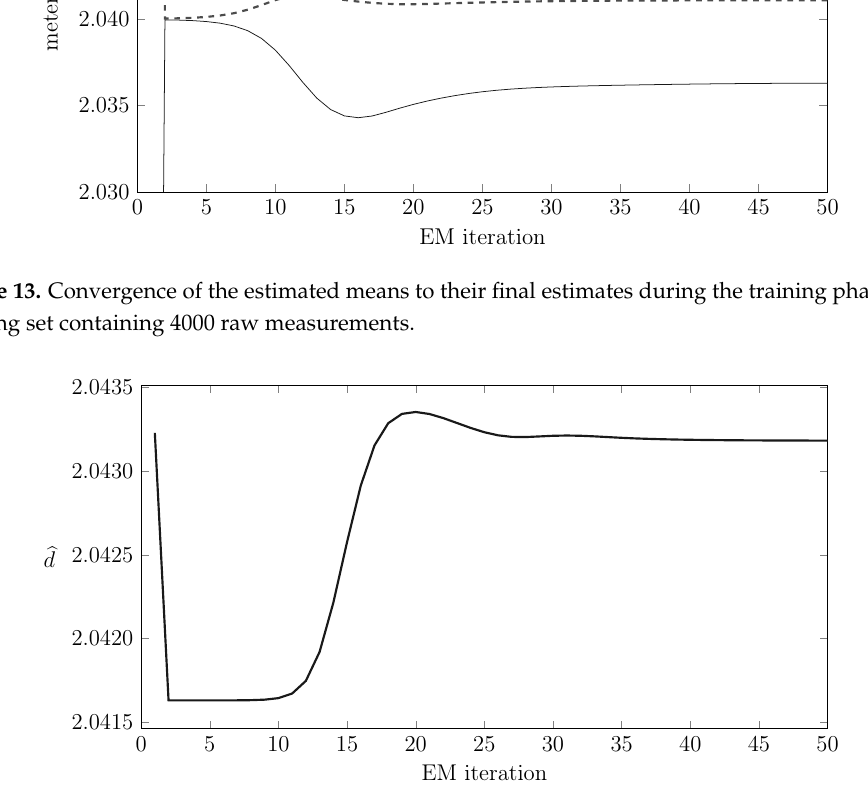
Figure 14. Convergence of the estimated distance to its final estimate during the test phase for a test set containing 4000 raw measurements.